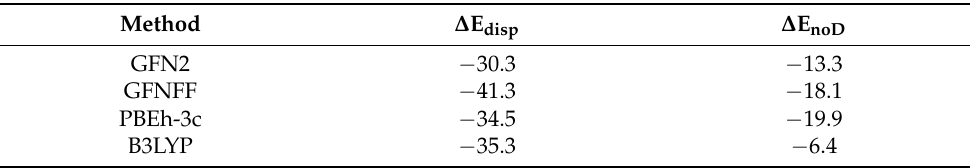
Figure 7. xTB-GFN2 optimized structure of the inclusion complex of extended melatonin into β -cyclodextrin. Table 4. Complexation energy (with ( ∆ E disp ) and without ( ∆ E noD ) dispersive contribution) calculated at the xTB-GFN2 optimized geometries with different methods. Values are in